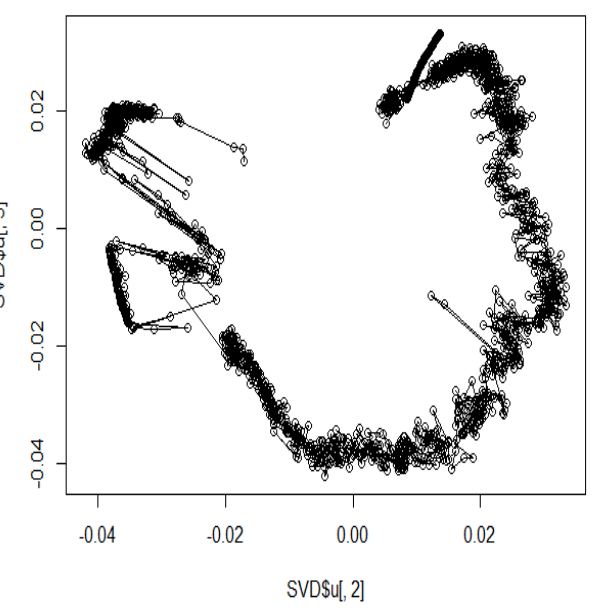
Figure 5. The hypothetical chromosomes 18 (0 bp–86,000